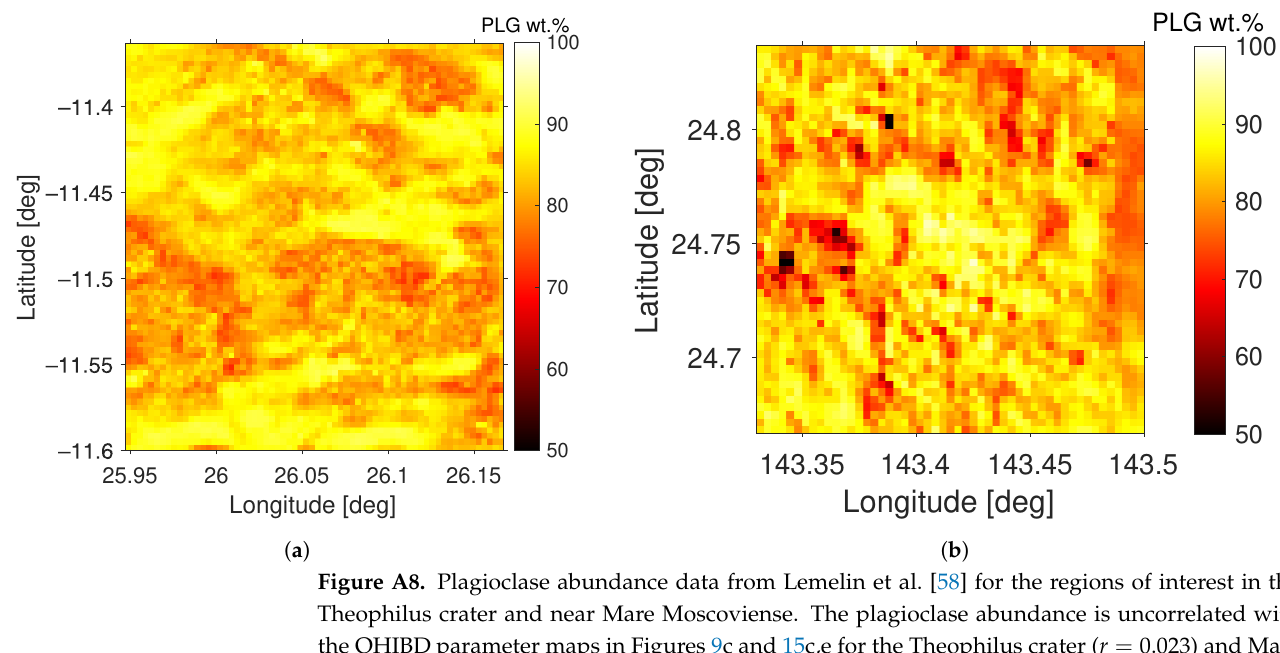
Figure A8. Plagioclase abundance data from Lemelin et al. [58] for the regions of interest in the Theophilus crater and near Mare Moscoviense. The plagioclase abundance is uncorrelated with the OHIBD parameter maps in Figures 9c and 15c,e for the Theophilus crater ( r = 0.023) and Mare Moscoviense in the morning ( r = 0.055) and at midday ( r = 0.019), respectively. ( a ) Theophilus crater, ( b ) Mare Moscoviense.